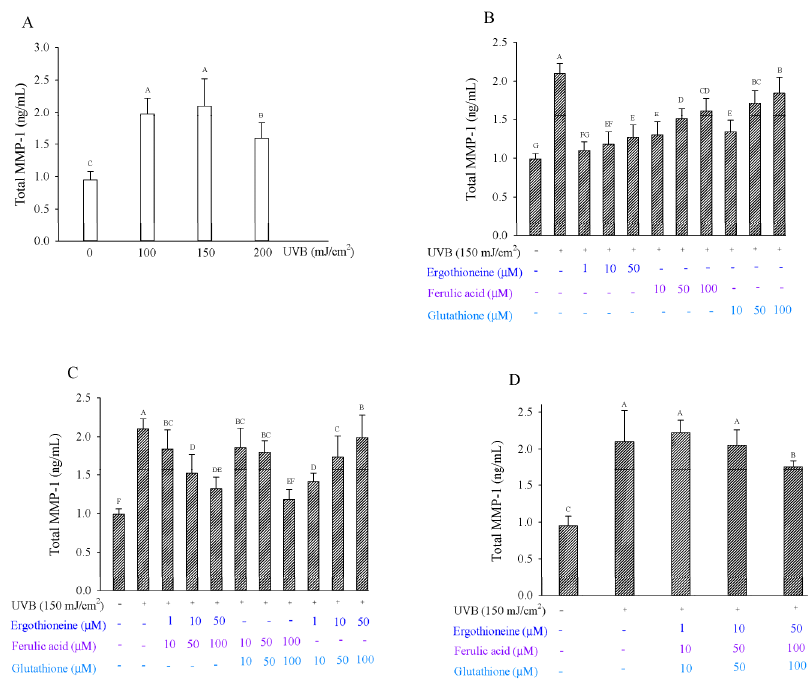
Figure 6. Total MMP-1 production by Hs68 cells after exposure to UVB at various irradiation dosages ( A ). Total MMP-1 production by Hs68 cells induced by UVB irradiation in the presence of a single ( B ), combination of two ( C ), or combination of three types of antioxidants ( D ), namely ergothioneine, ferulic acid, and glutathione. Each value is expressed as the mean ± SD ( n ≥ 3). Different letters indicate significant differences among treatments ( p < 0.05).